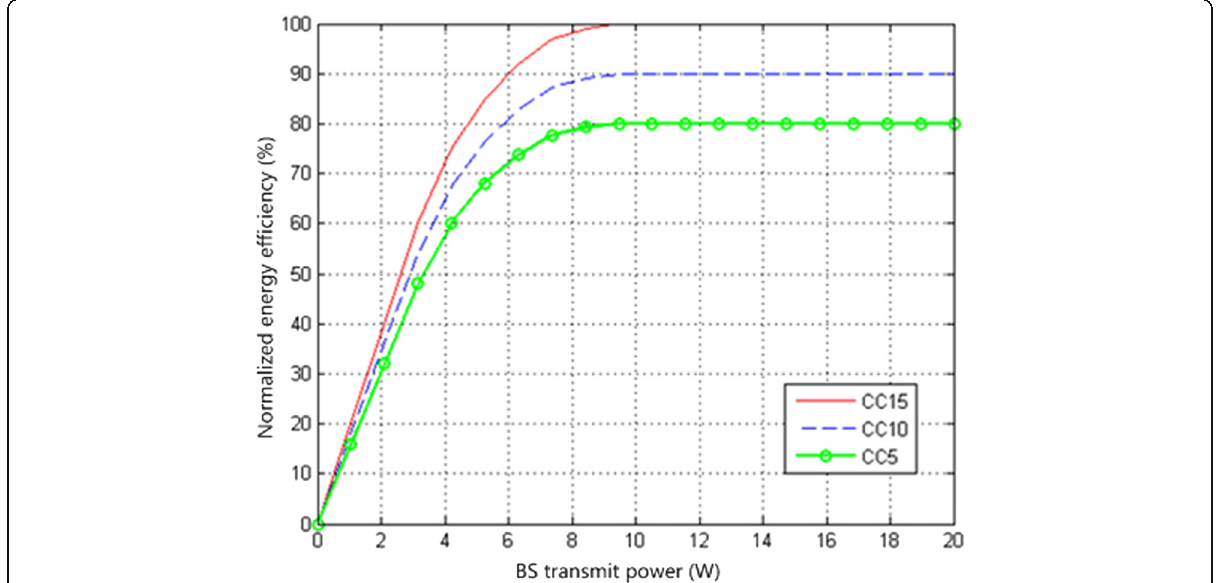
Fig. 4 System energy efficiency v.s.BS transmit power with different number of available carrier frequencies